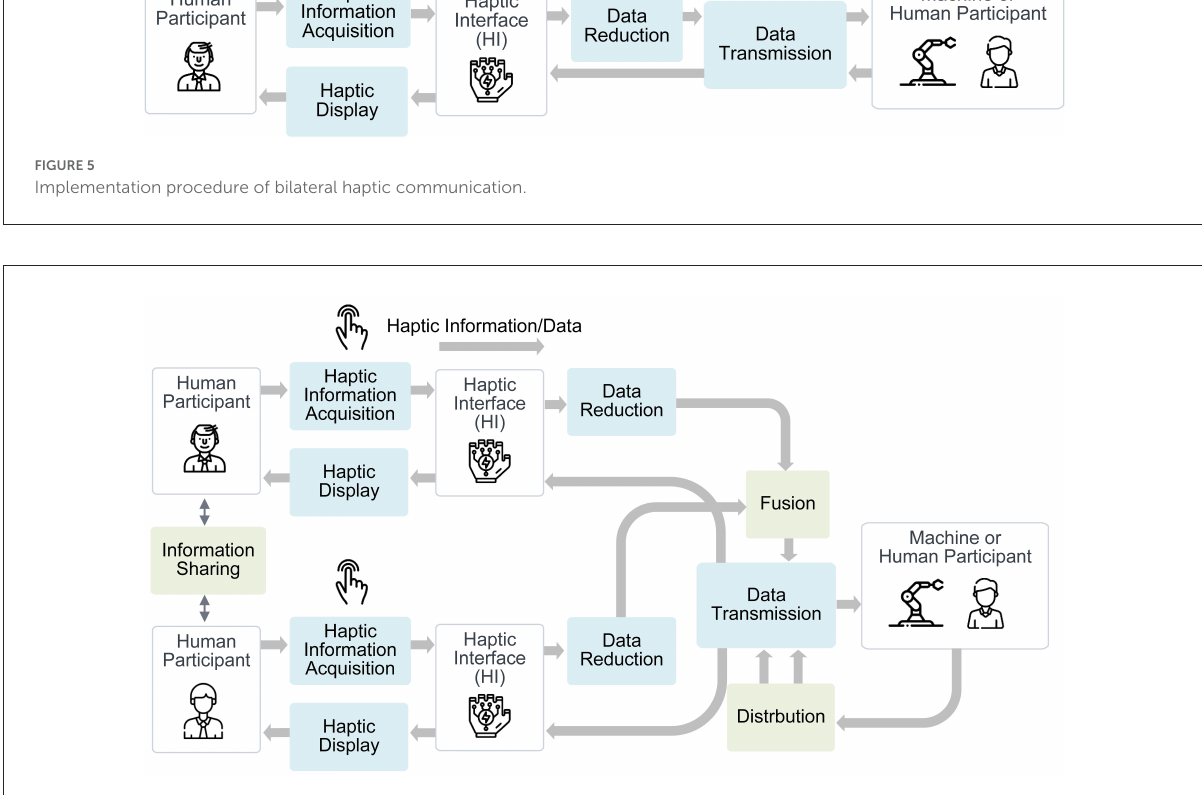
FIGURE6 Implementation procedure of multilateral haptic